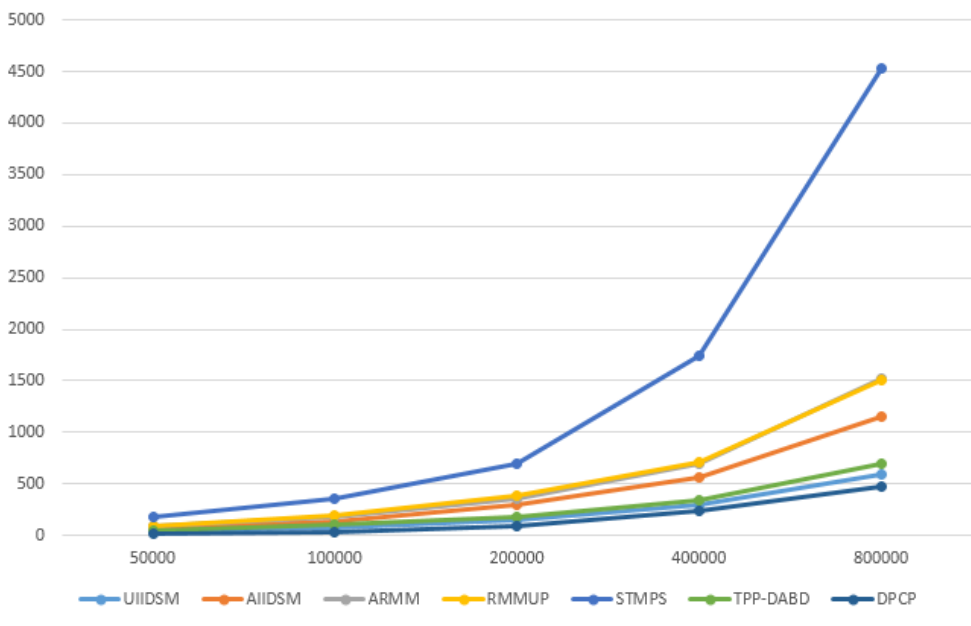
Figure 5. The operation times of the seven